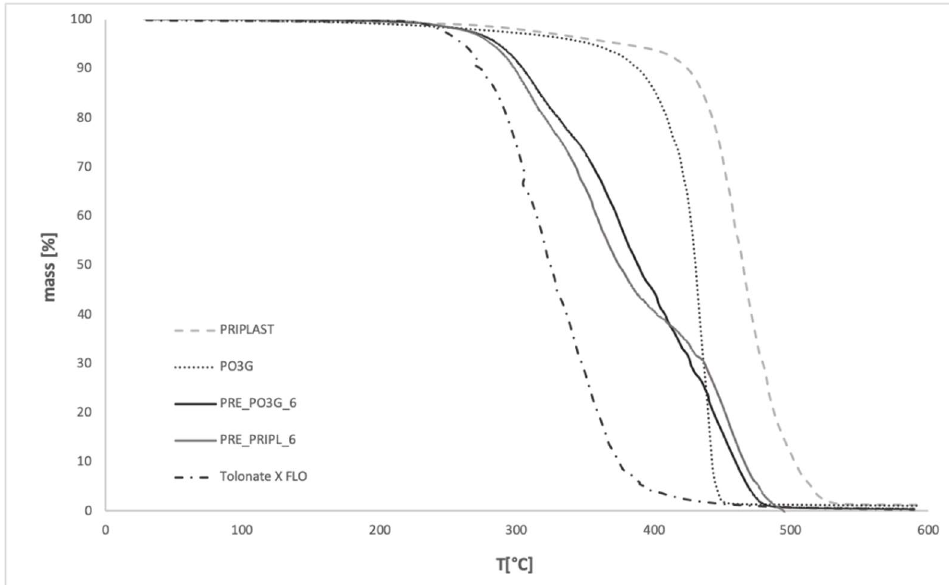
Figure 7. Dependence of TG in function of temperature for monomers and the obtained bio-based prepolymers with NCO ca. 6%.